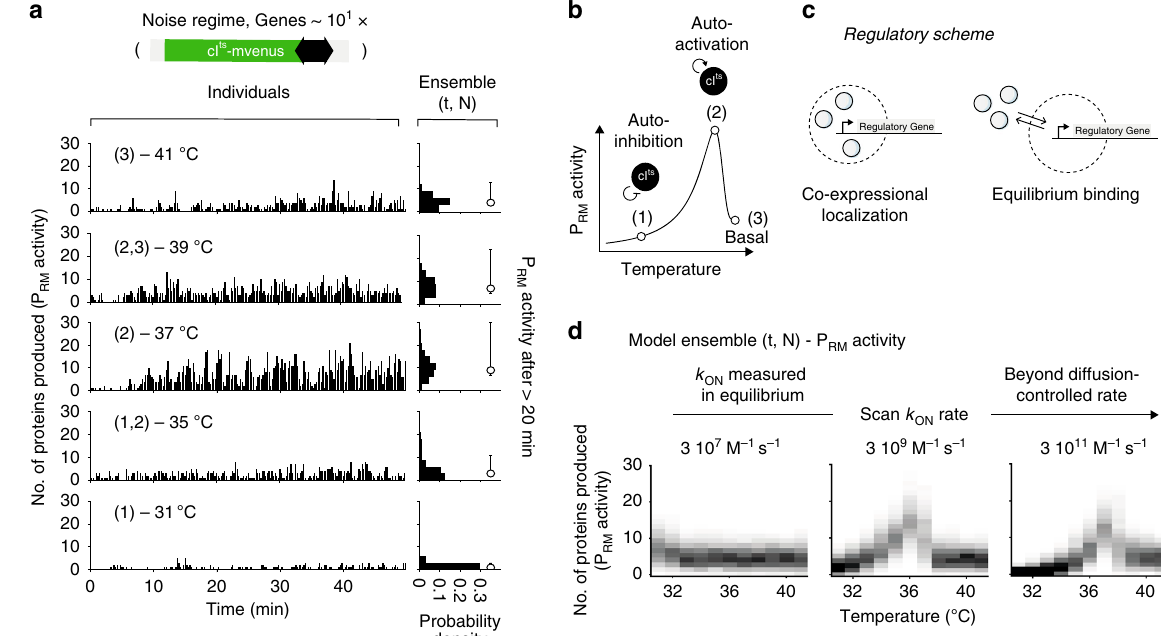
Fig. 3 Monostable GRN and co-expressional localization at the low-density limit. a Production rate of CI ts -mVenus proteins in 15 s inside individual compartments (left column) and ensemble production rates (right column) as in Fig. 2c. Circle with error bars give the median and the 32th to 68th percentile of the ensemble production rates ( N = 1044, 1392, 1044, 1044, 1044 in the order of increasing temperature). b Illustration of the expected P RM activity with temperature in the monostable GRN and the corresponding states. c A protein repressor synthesized in proximity to its DNA-binding site, reach higher effective concentrations by co-expression localization (left scheme) than in an equilibrium scenario due to diffusion away from the DNA (right scheme). d Ensemble production rates obtained from stochastic simulations with a scan in the CI ts binding rate to the DNA-binding sites. Source data are provided as a Source data fi